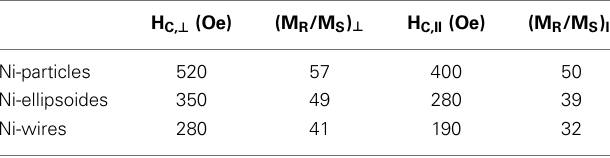
Table 1 | Coercivity and remanence in easy axis (magnetic field applied parallel to the pores) and hard axis (magnetic field perpendicular to the pores) magnetization in dependence on the Ni-structure length